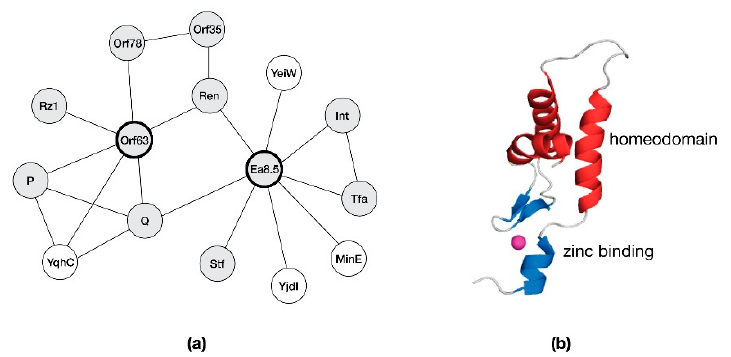
Figure 2. Potential interactions of exo-xis proteins identified from yeast two-hybrid studies. ( a ) An interaction map of host proteins (open circles) and phage proteins (shaded circles). ( b ) The NMR solution structure of Ea8.5 (PDB: 2M7A) reveals an unusual hybrid homeodomain-like / zinc-finger fold.